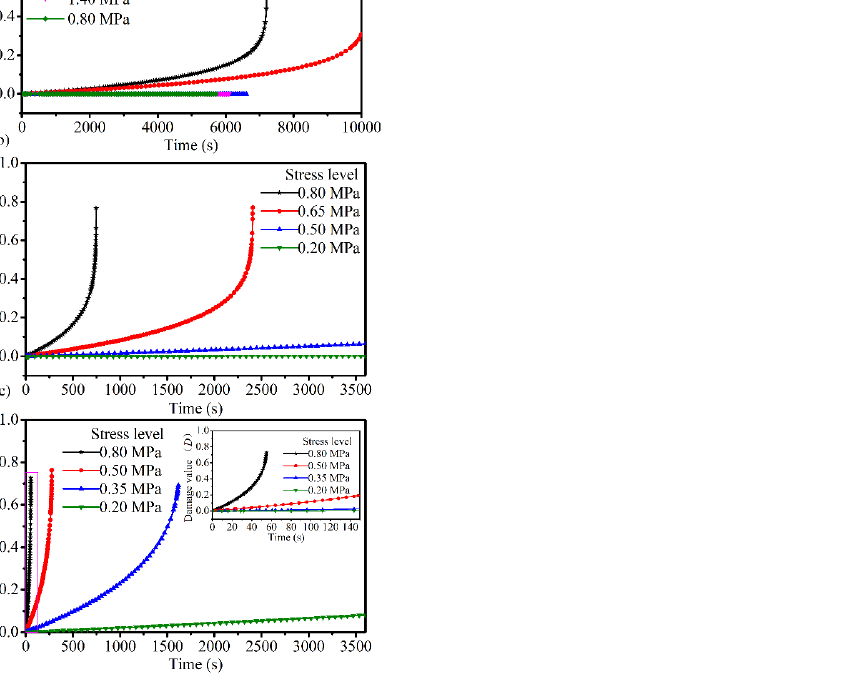
Figure 12. Variation curves of damage values with time under different compressive stress levels at ( a ) 10 °C, ( b ) 30 °C, and ( c ) 50 °C.